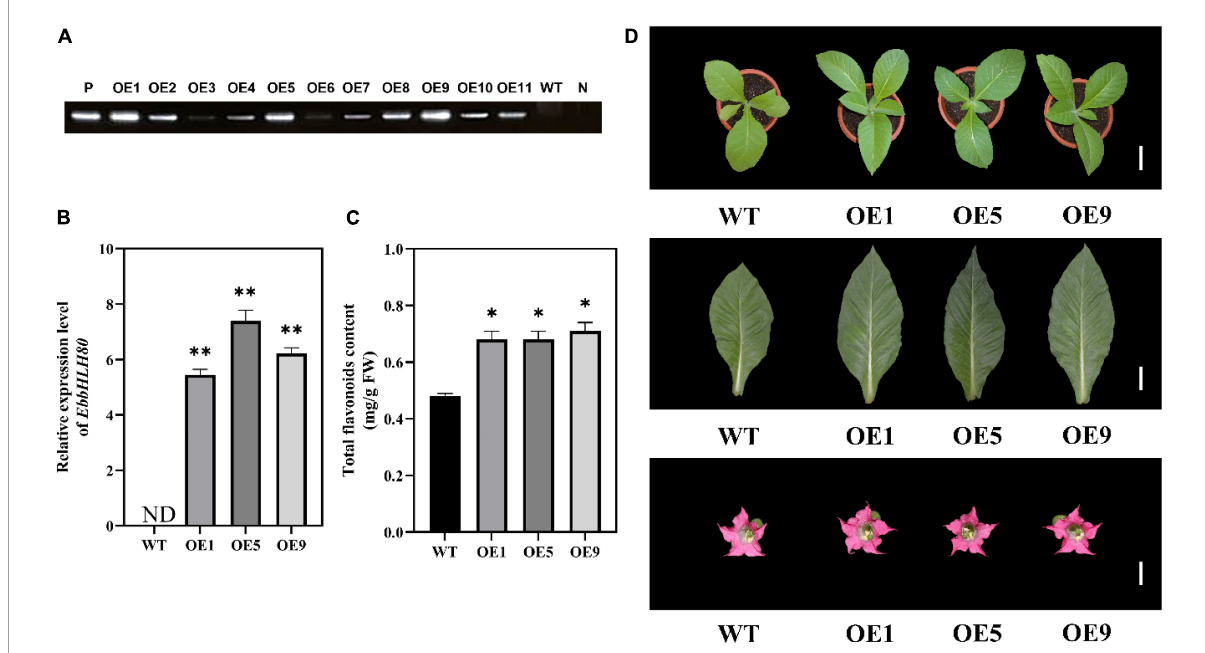
FIGURE5 Characterization of transgenic tobacco lines overexpression EbbHLH80 . (A) PCR amplification of EbbHLH80 in transgenic lines (OE1-11) and WT plants. P, positive control. N, negative control (double-distilled water, ddH 2 O). (B) Relative expression level of EbbHLH80 in WT and EbbHLH80 –OE (OE1, OE5, and OE9) tobacco transgenic plants. (C) Total Flavonoids content in leaves from 7-week-old plants from WT as well as EbbHLH80 –OE (OE1, OE5, and OE9) tobacco transgenic plants. (D) The phenotypes of OE1, OE5, and OE9 tobacco transgenic plants and WT. Bar = 1 cm. Data represent mean ± SD of three biological replicates and the one-way analysis of variance was used for statistical analysis ( ∗ P < 0.05 and ∗∗ P <